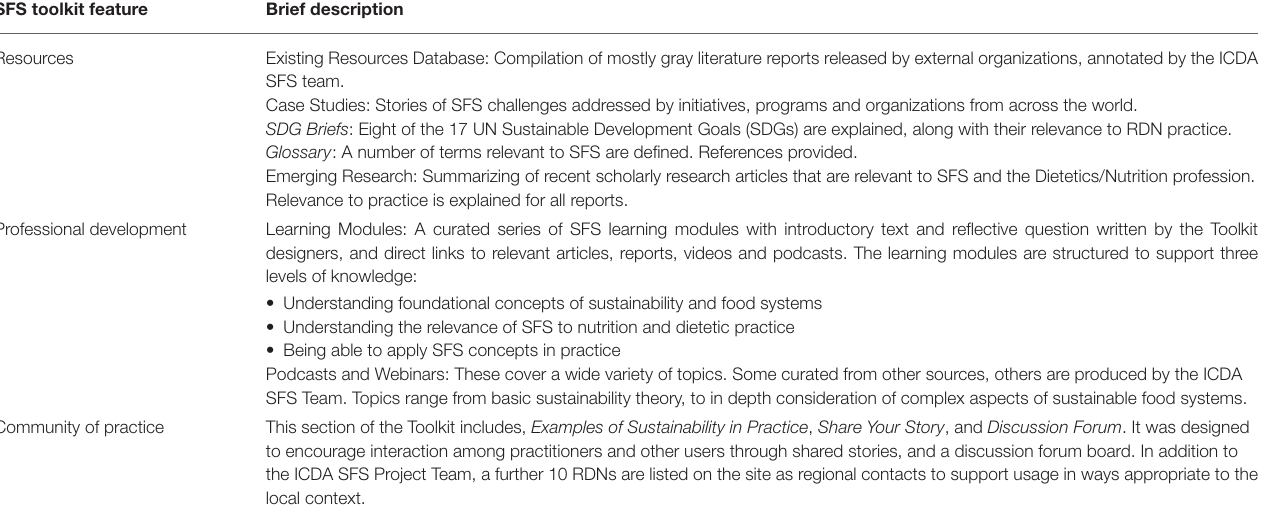
TABLE 4 | Elements of the ICDA SFS toolkit, overview of features/elements used in data